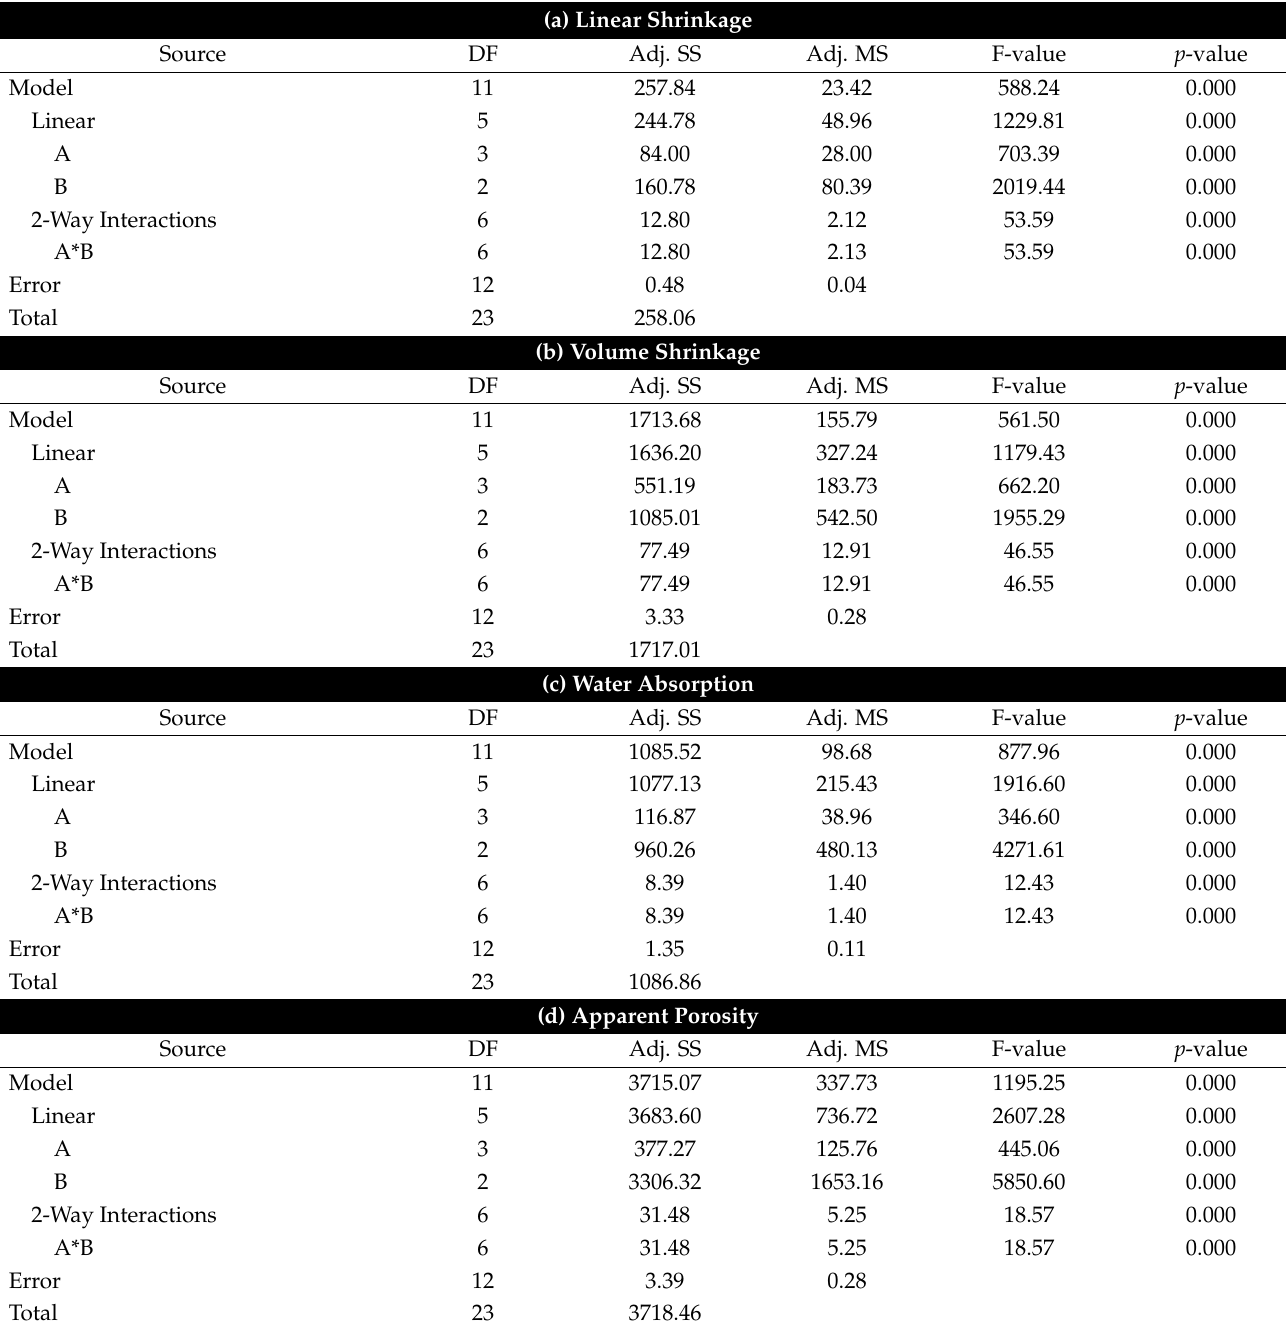
Table 4. ANOVA for linear shrinkage, volume shrinkage, water absorption, apparent porosity, bulk density and